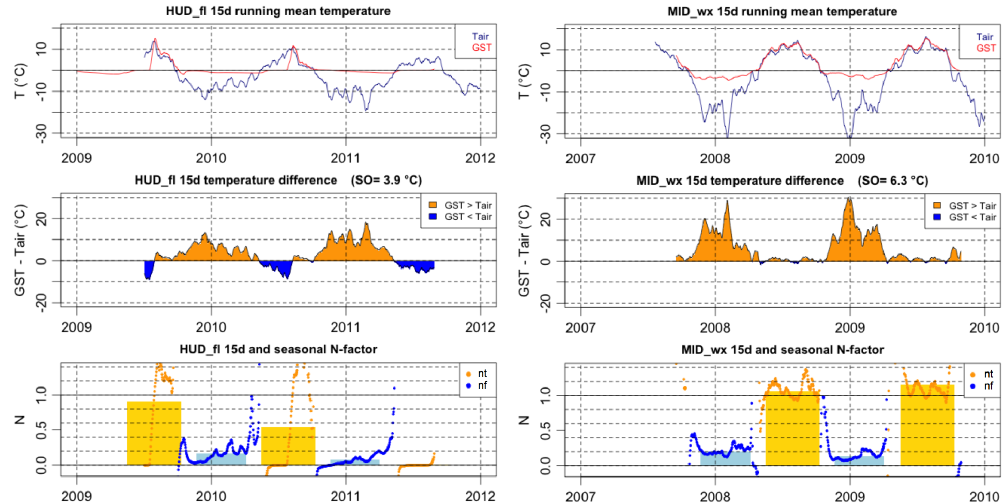
Figure 6. Seasonal development of temperature differences and N factors at flat rock on Hudson Bay Mountain (left) and in a flat meadow at Middlefork (right). Top: air and ground-surface temperature (15-day running mean); middle: temperature difference (GST– T air ) on 15-day running average; bottom: N factors on seasonal average (bars) and 15-day average (points). The SO is to partly controlled by the winter air temperature and is larger at MID_wx (orange area; middle). Negative differences in early summer (blue area; middle left) contribute to a smaller SO at HUD_fl. Freezing N factors ( nf ) are on a similar level (0.1–0.2), whereas thawing N factors ( nt ) differ due to the persistence of the snow during summer at